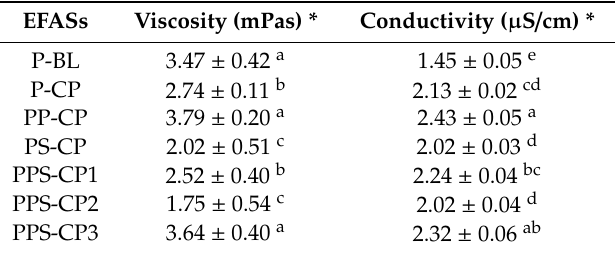
Table 2. Viscosity and conductivity of EFASs.